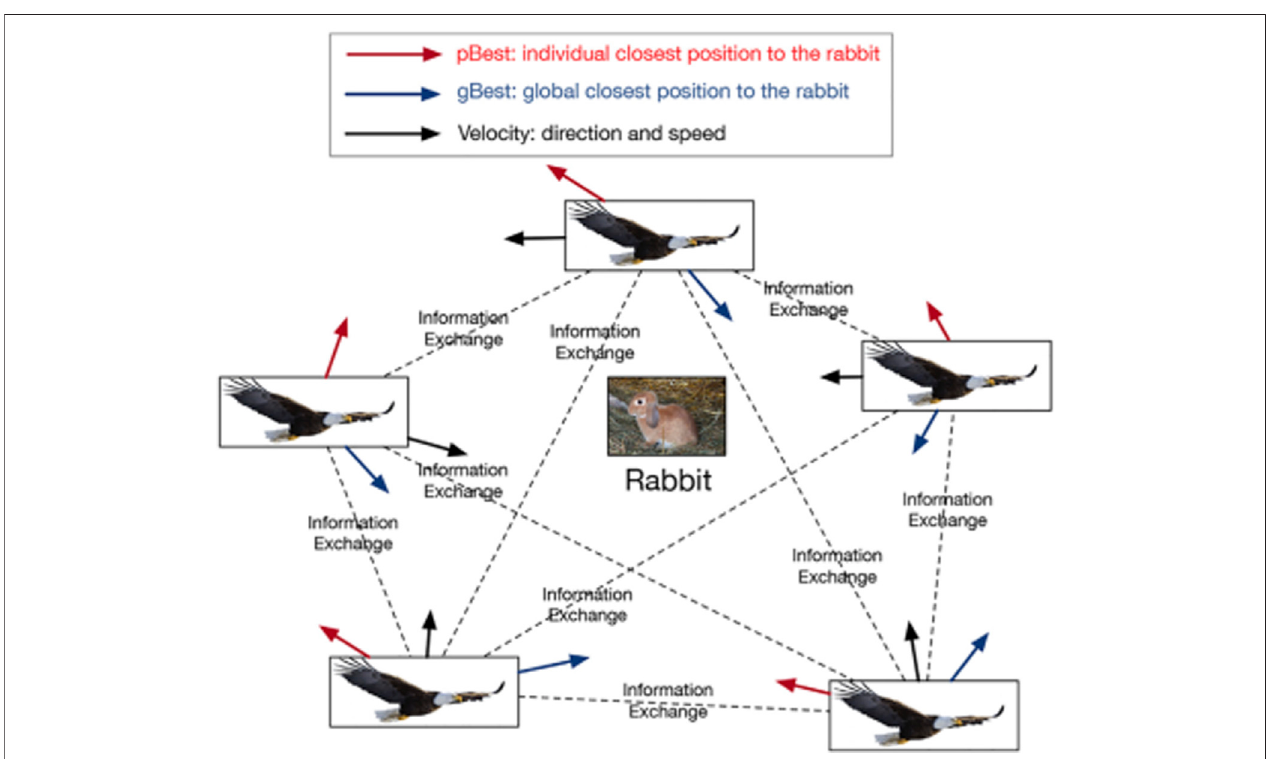
FIGURE3 | The origin ofPSO: a fl ock ofeagles ispreying on arabbit. Tocapturingthe rabbit quickly, each eagle records where isthe closest position tothe rabbit during its historyexploration(pBest). Meanwhile,alleaglesshare theclosestpositiontotherabbitwhere the fl ockknew (gBest). Alleagles exploreany positionbased on their velocity, pBest, and gBest until the rabbit is captured.